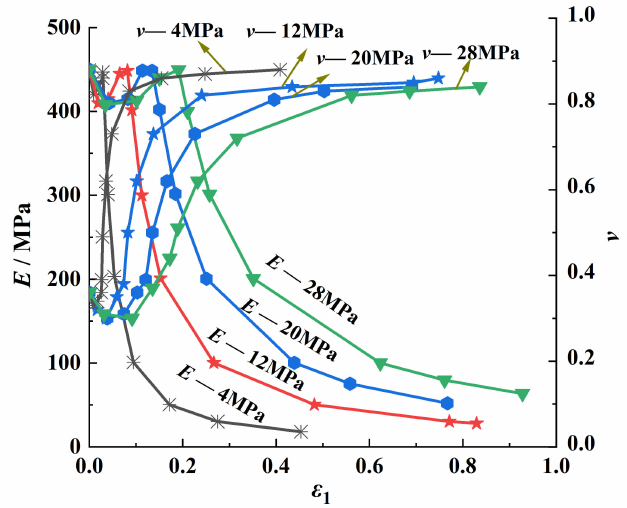
Figure 6. Variations in E and v with axial strain under different confining pressures.